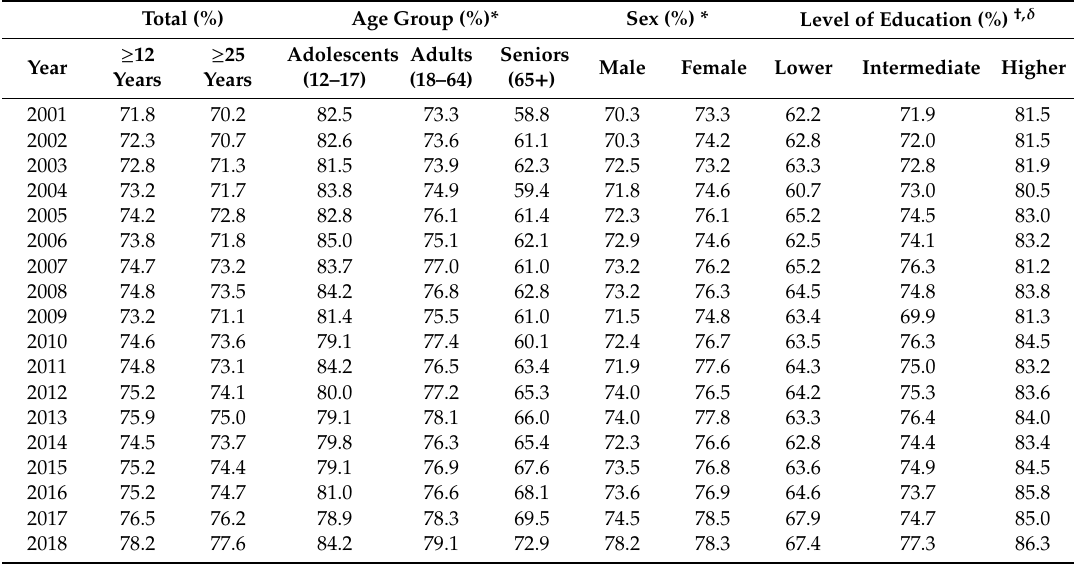
Table A4. Adherence levels to the second component of the Dutch physical activity guidelines consisting of two times per week bone and muscle strengthening activities for adults, three times for adolescents, stratified by age groups, sex, and level of education.